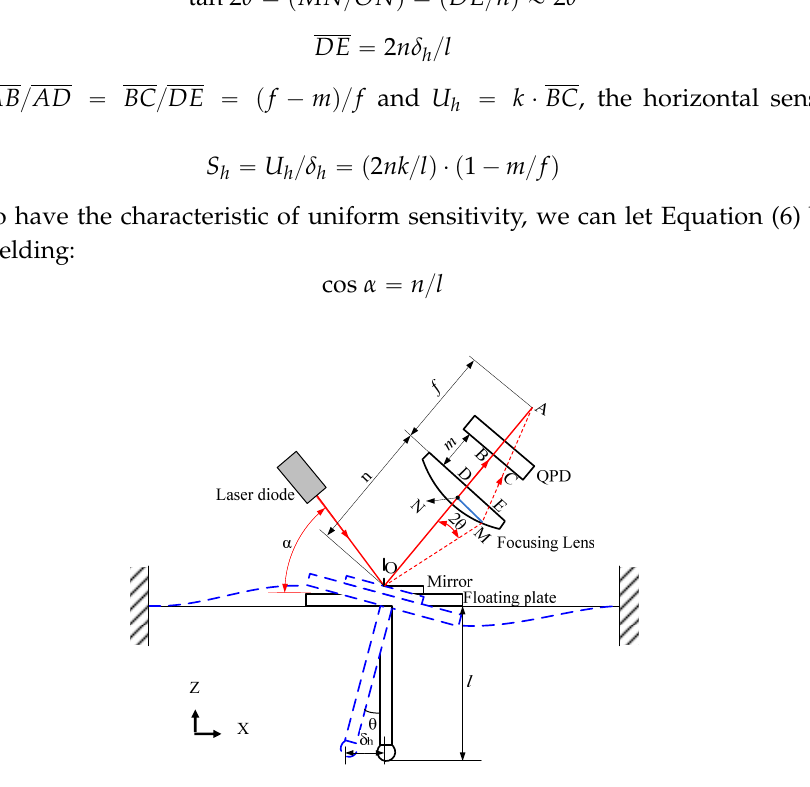
Figure 4. Detecting principle of the probe in horizontal tilt motion.